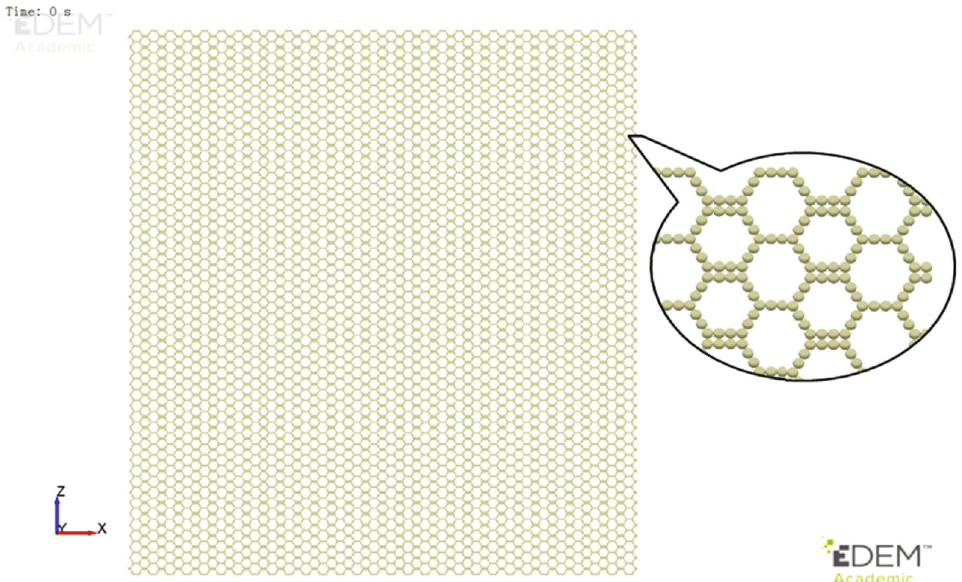
Figure 5: Discrete element model of single-layer honeycomb